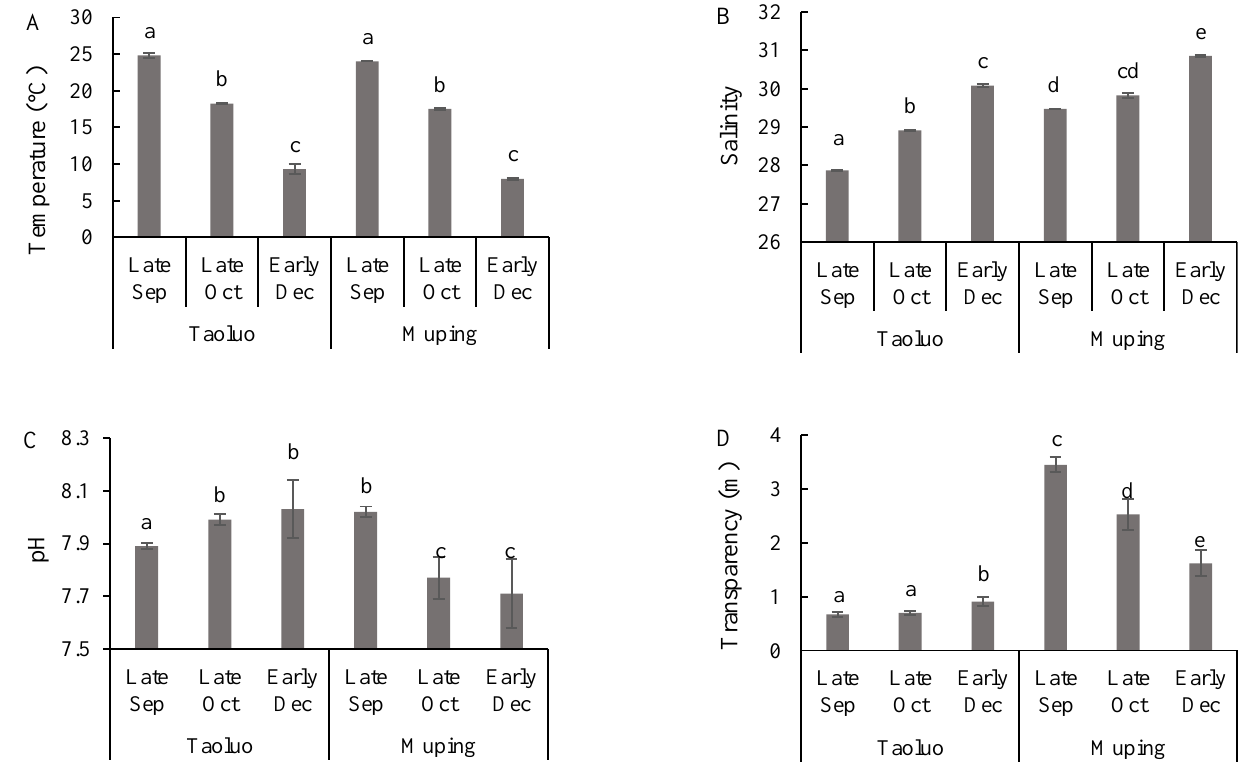
Figure 2. Water temperature ( A ), salinity ( B ), pH ( C ), and transparency ( D ) in Taoluo and Muping laver farming area in September (Sep), October (Oct), and December (Dec). The different letters in each row shows that the values are significantly different ( p < 0.05).